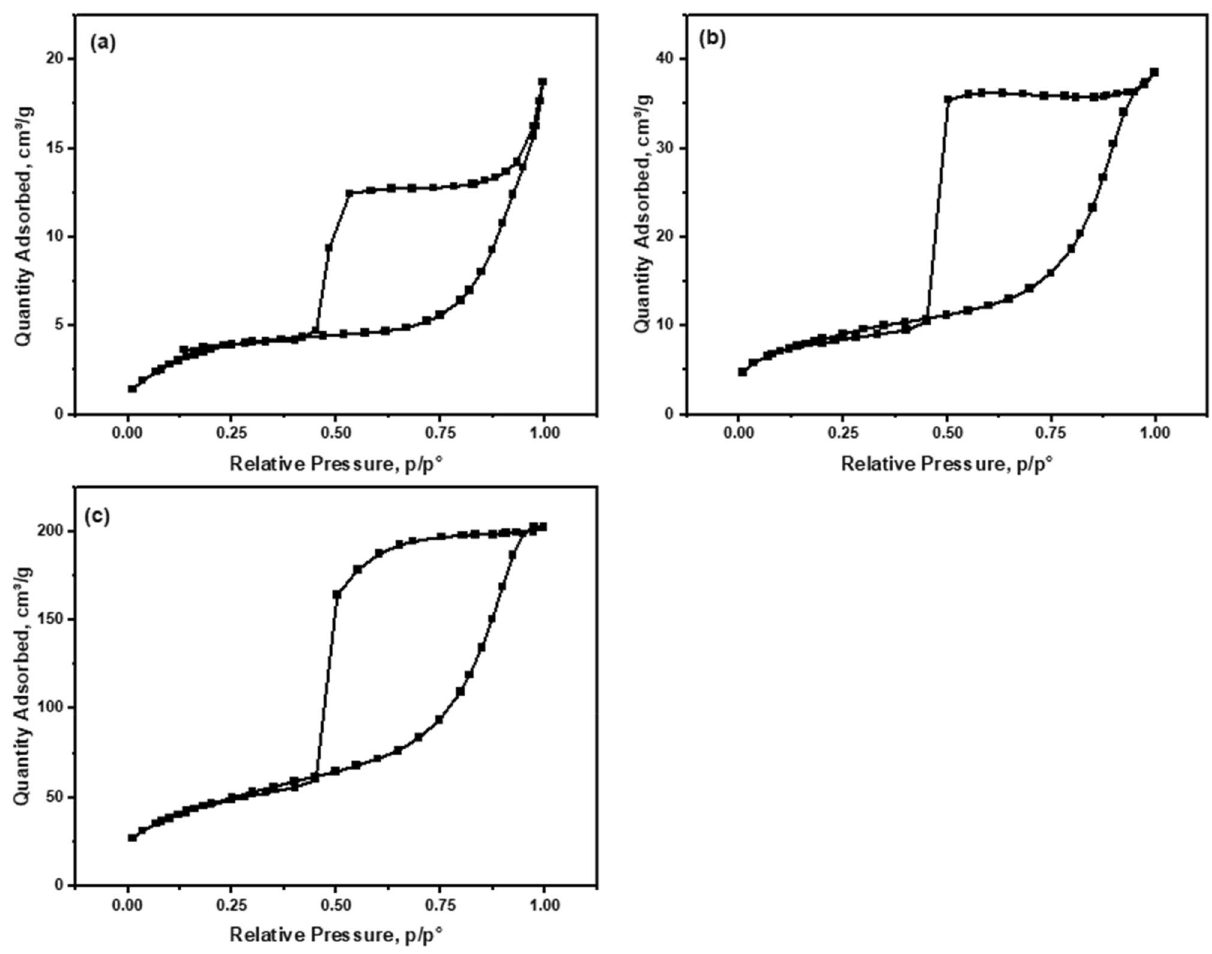
Figure 2. Magnetic hysteresis of ( a ) CMN10, ( b ) CMN15, and ( c ) CMN20.